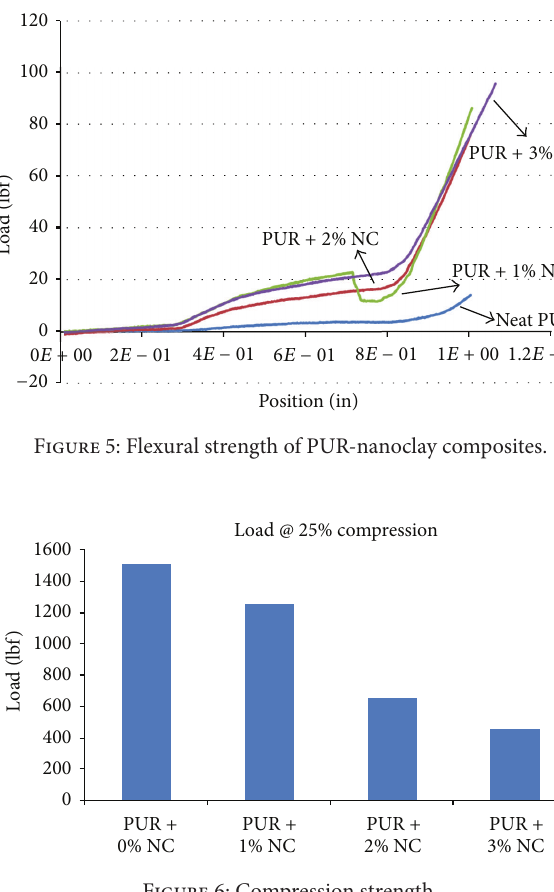
Figure 6: Compression